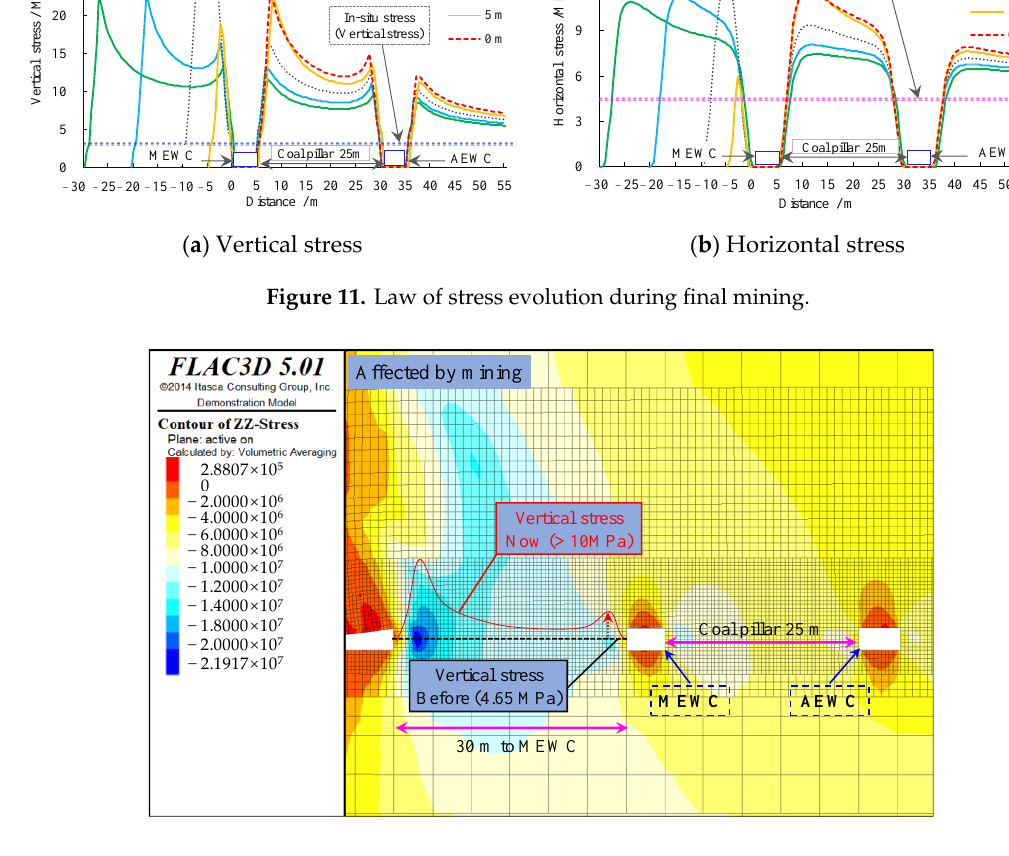
Figure 12. The vertical stress